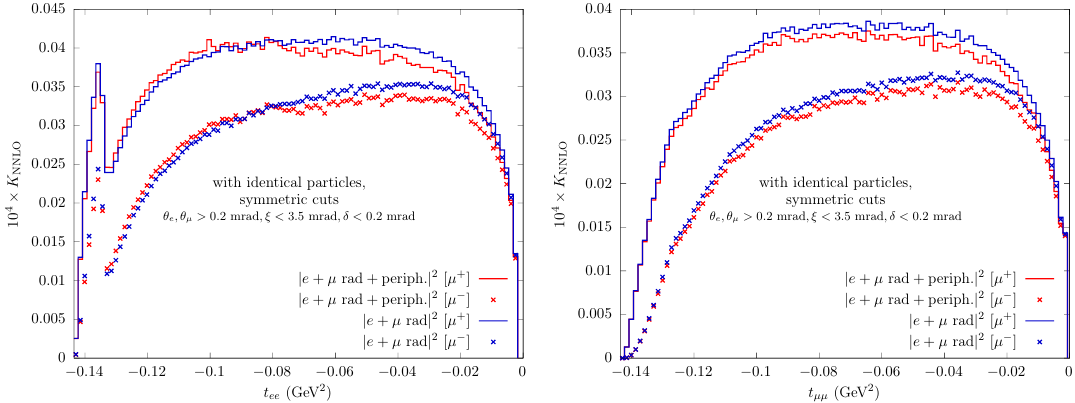
Figure 24. Left: differential K NNLO factor on t ee distribution for real e + e − radiation with realistic event selection, with all cuts applied. Right: the same for t